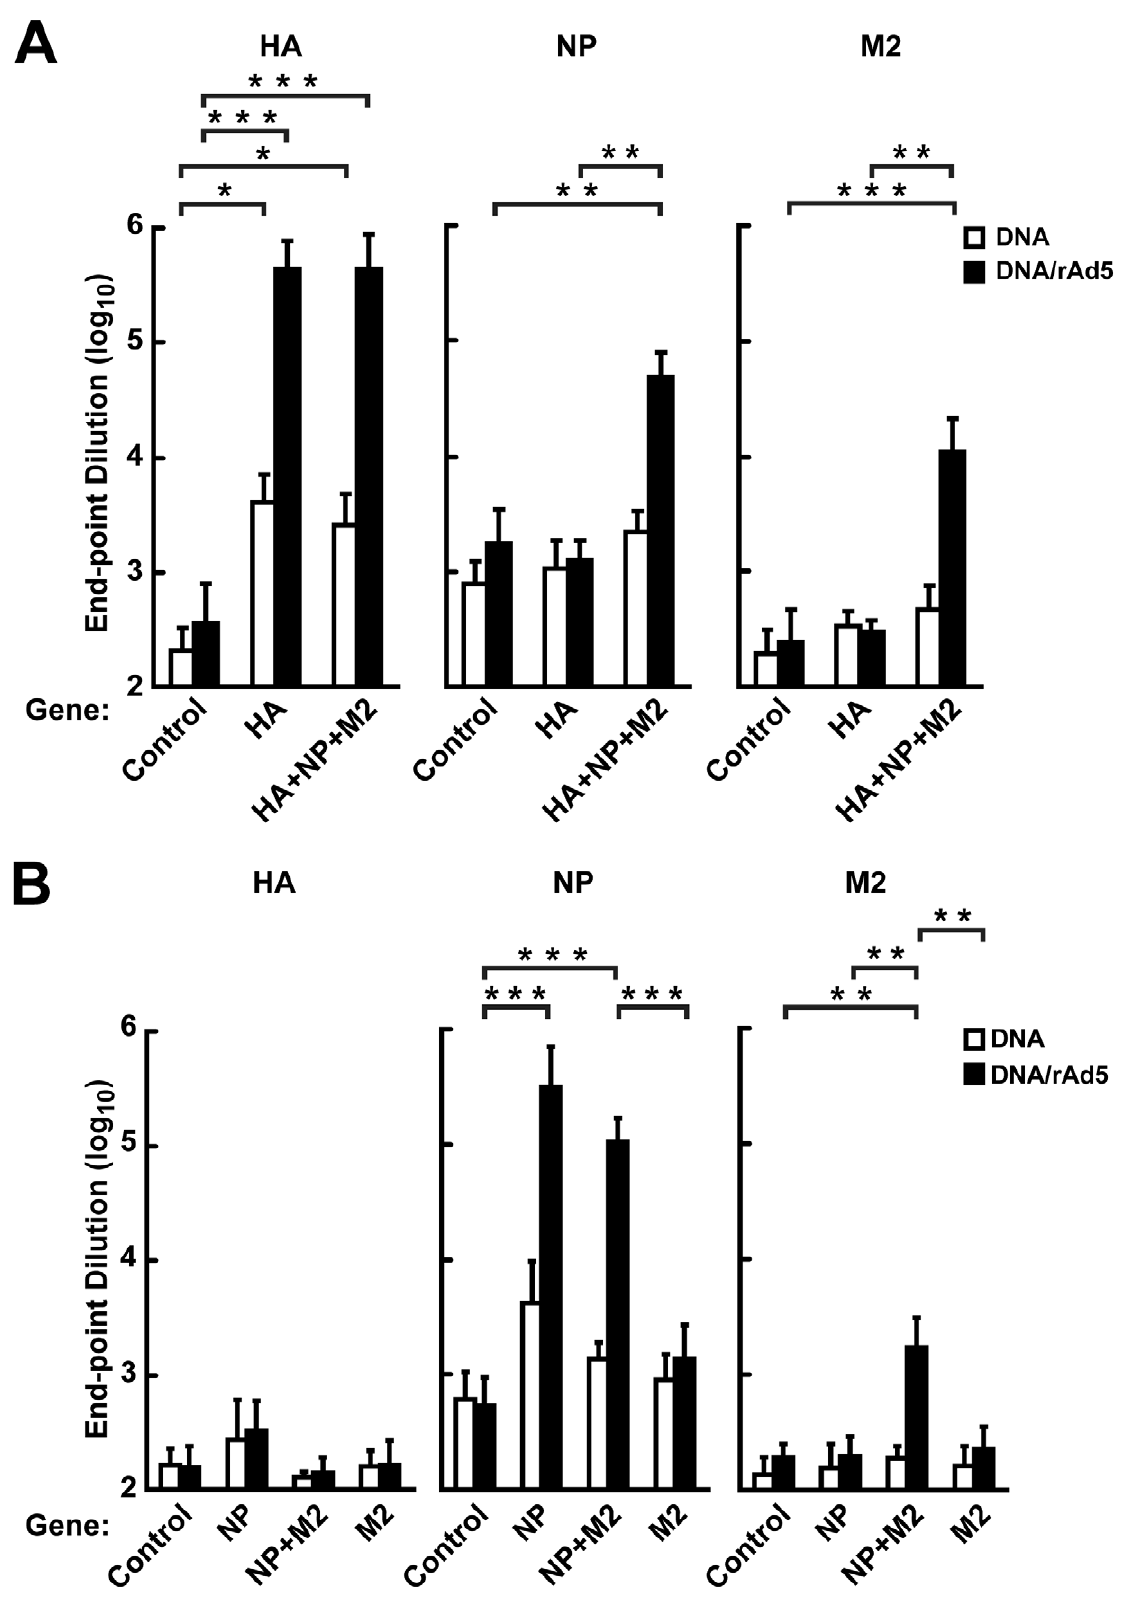
Figure 4. Humoral immune responses to HA, NP and M2 confirmed by ELISA after DNA/rAd5 immunization in ferrets. (A) Sera from the HA, HA + NP + M2 or vector control immunized ferrets were collected 14 days after the third DNA immunization (white bars), and 14 days after the recombinant adenovirus boost (solid bars), and subjected to ELISA assays to determine their end-point titer levels against HA(KAN-1), NP(KAN-1), and